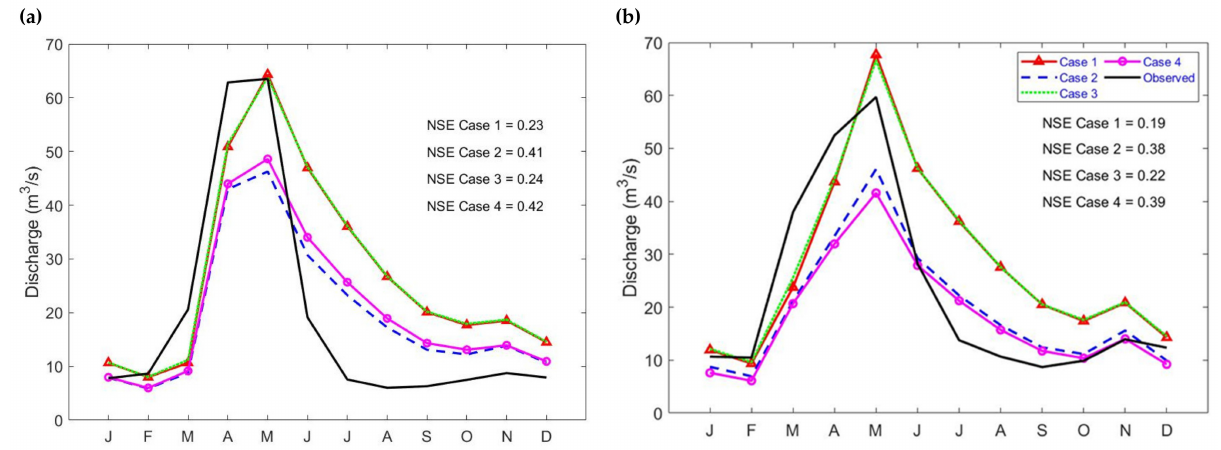
Figure 3. Observed and simulated average monthly discharge of designed 4 cases. ( a ) Calibration ( b )